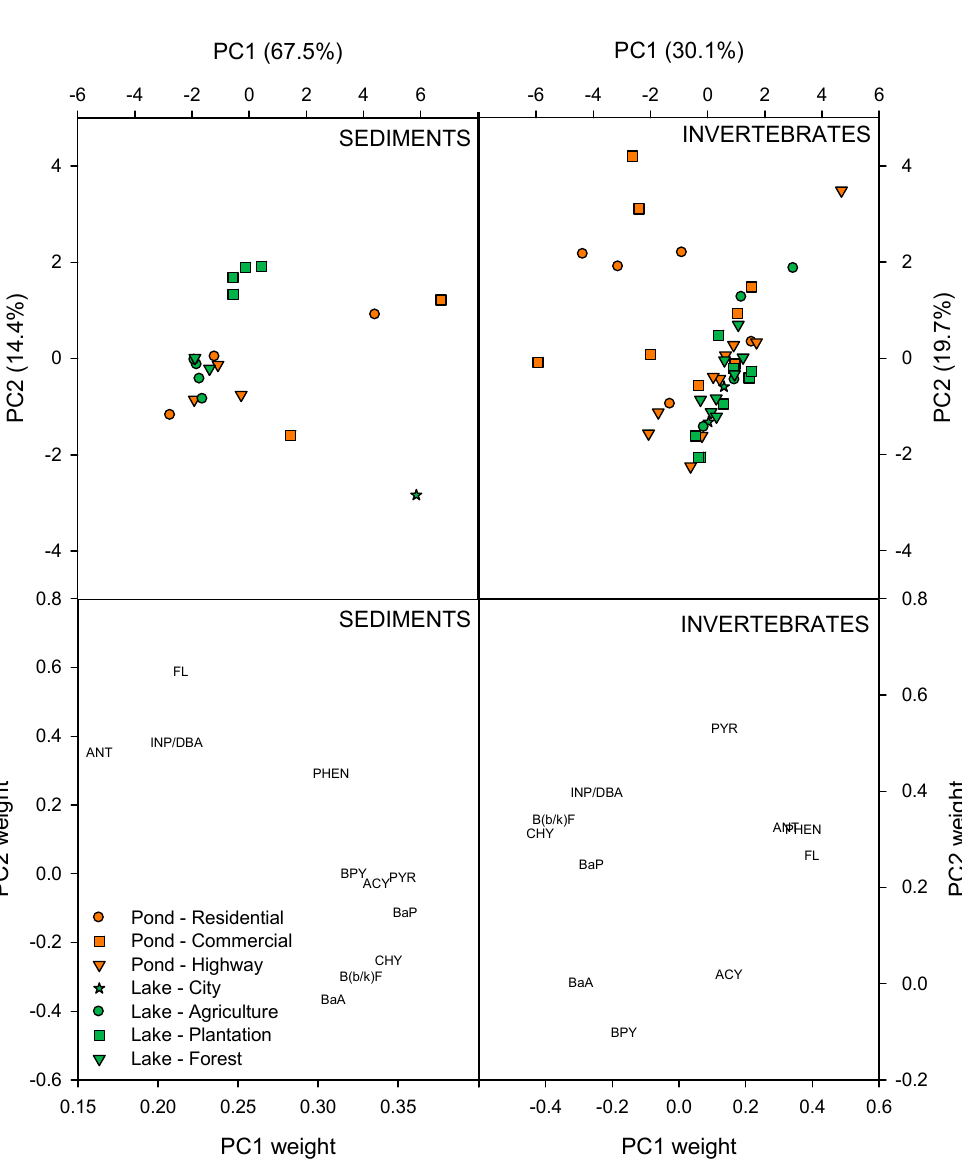
Figure 4. Principal component analysis of PAHs in sediments and invertebrates of the SWRPs and the natural, shallow natural, shallow lakes.